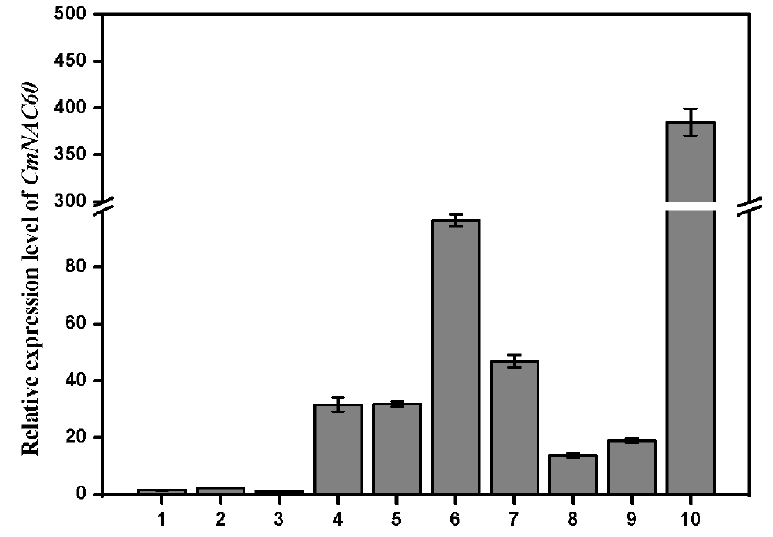
Figure 2. Relative expression levels of CmNAC60 in different organs of oriental melon. The numbers represent the following: (1) seeds, (2) cotyledon (3) hypocotyls (4) young leaves, (5) stem (6) root (7) tendril (8) 15 d fruit after pollination, (9) female flower, and (10) male flower. The expression levels are calculated relative to the CmNAC60 expression in the hypocotyls, which was set as 1. The 2 − ∆∆ CT method was used in the qRT-PCR analysis. Data are mean ± standard deviation (SD) from three biological replicates. Bars indicate standard deviation.